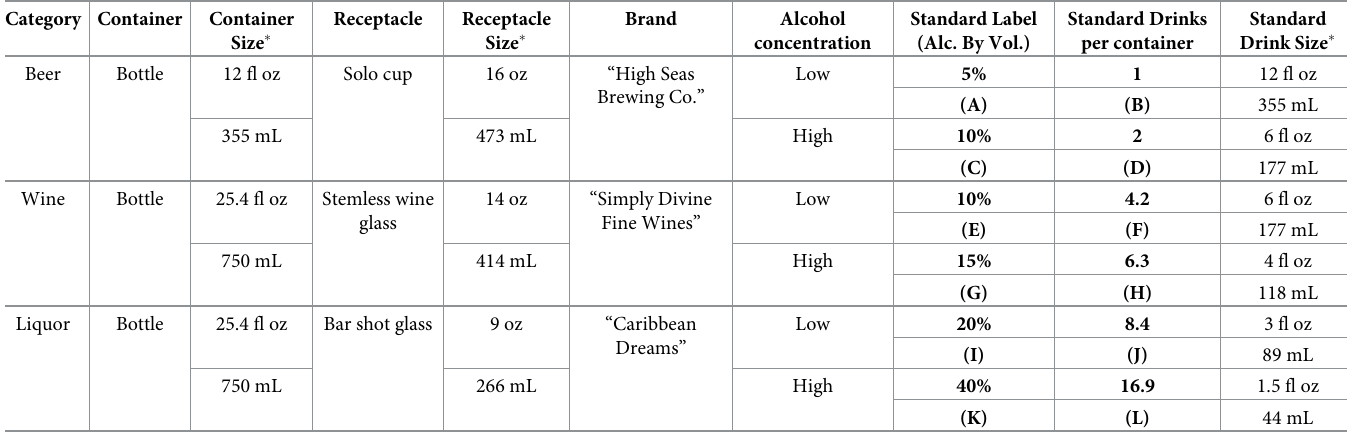
Bold font indicates the 12 different label variations used in the study. The ABV and standard drink labels indicate the same amount of alcohol per container in low and high formats. Each letter corresponds to the stimulus labels located in Table 2. �